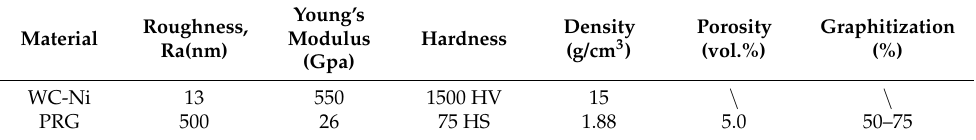
Table 1. Mechanical and physical properties of test materials.